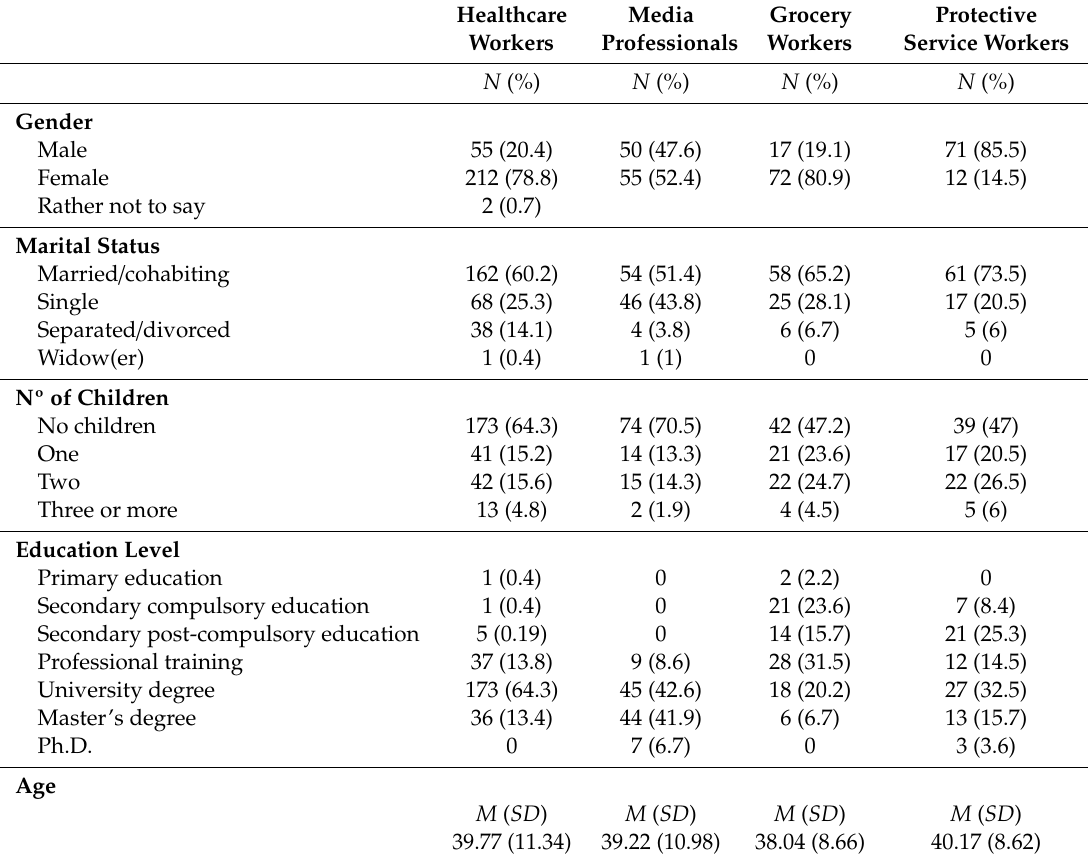
Table 1. Sociodemographic characteristics of the four subsamples.